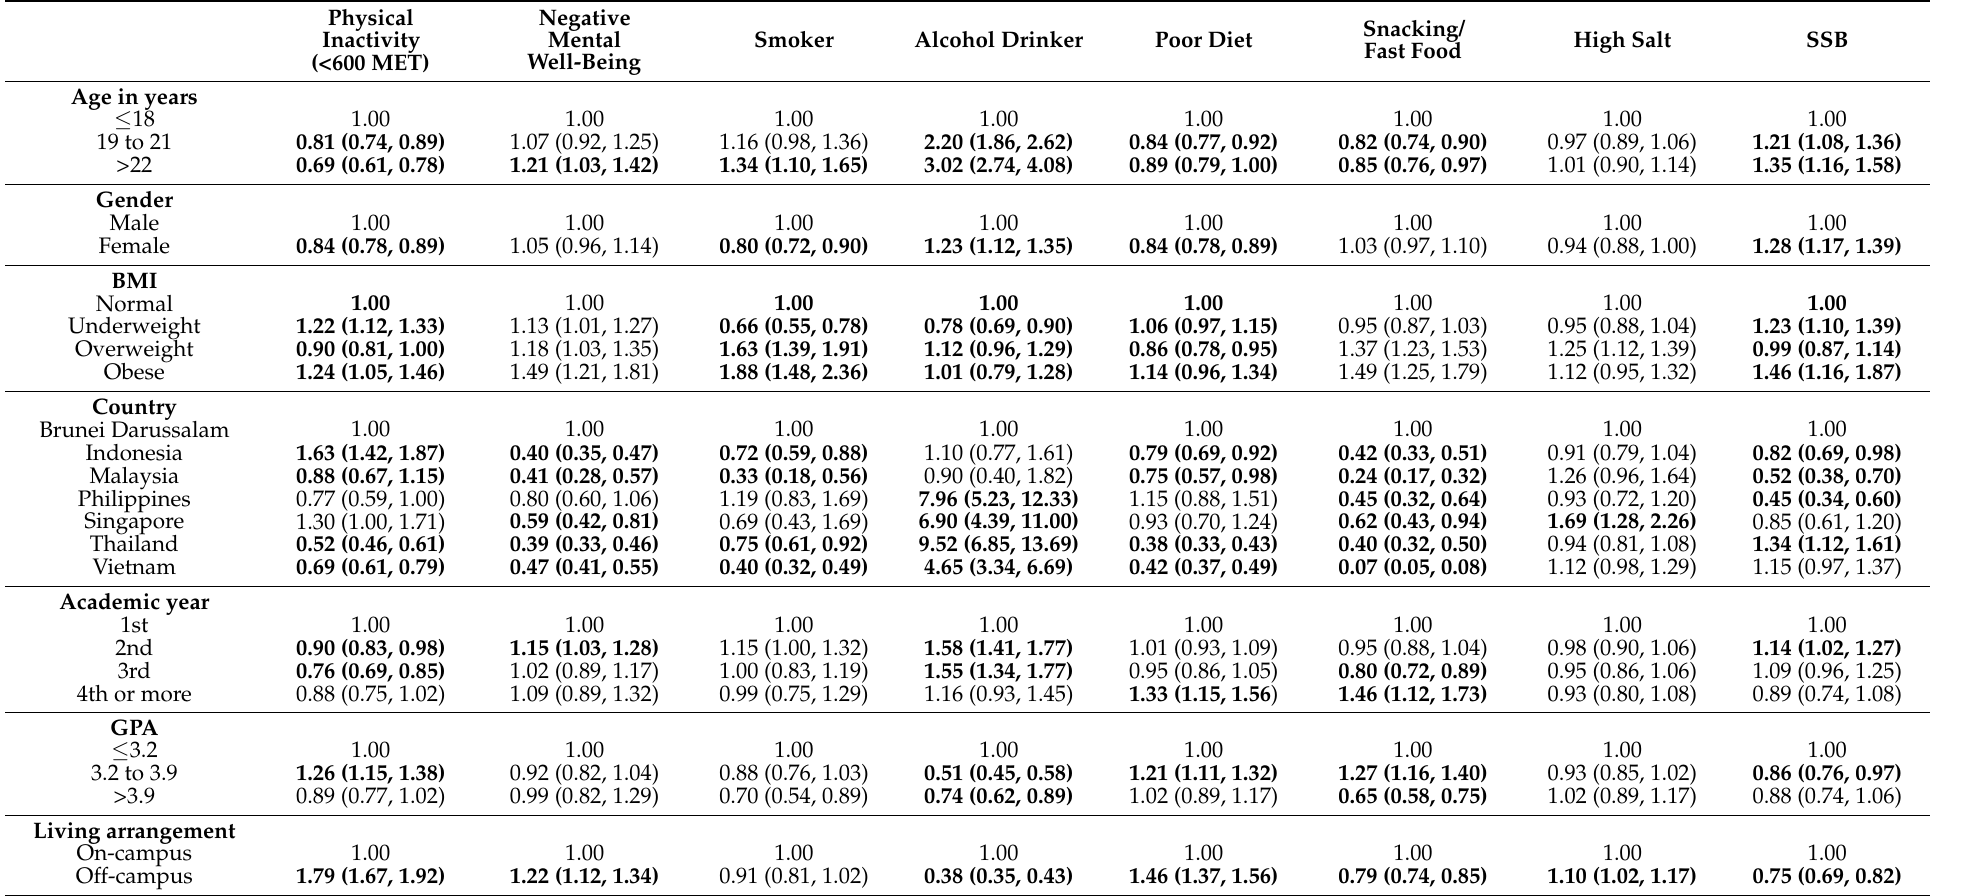
Snacking/ High Salt Fast Food